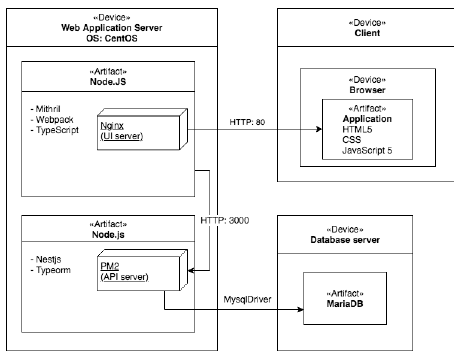
Figure 2. Deployment